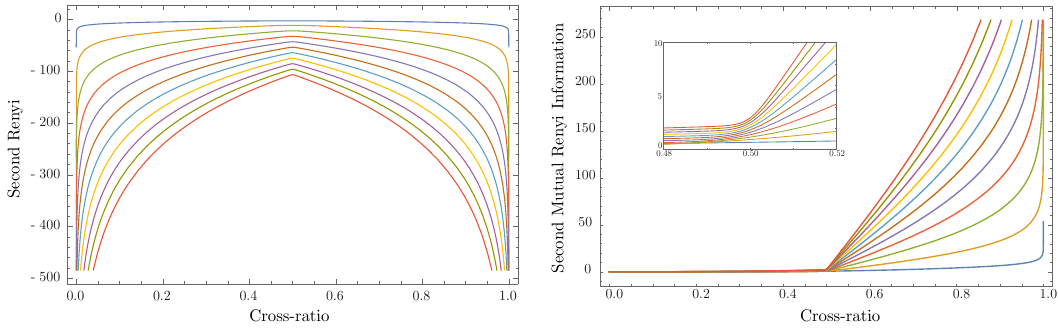
Figure 2 . (Left) Second R(cid:19)enyi entropies and (Right) Mutual R(cid:19)enyi Information for k = 1 ; 5 ; 10 ; 15 ; 20 ; 25 ; 30 ; 35 ; 40 ; 45 ; 50 ; 55 ; 60 as a function of x . The inset in (Right) shows the smooth behavior around x = 1 =